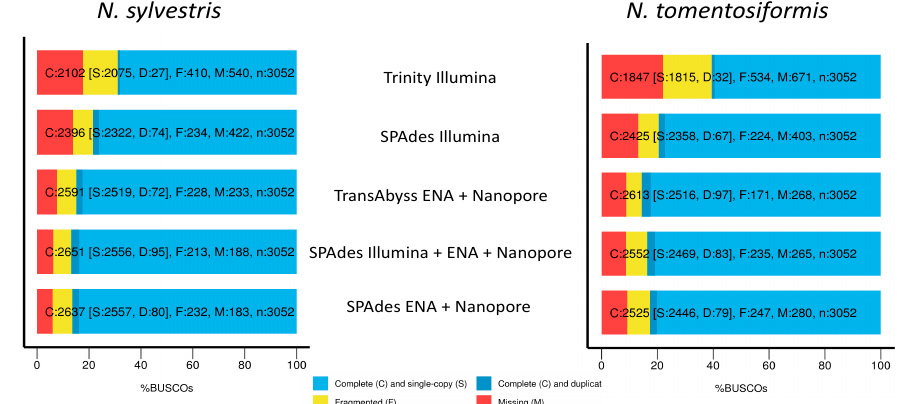
Figure 3. Percent complete single copy, fragmented, and missing BUSCO genes for both N. sylvestris and N. tomentosiformis across the five different assemblies performed: including the Nanopore long ‐ reads gave an increase of complete single copy genes and decrease in missing genes compared to short ‐ read only, regardless of assembler.